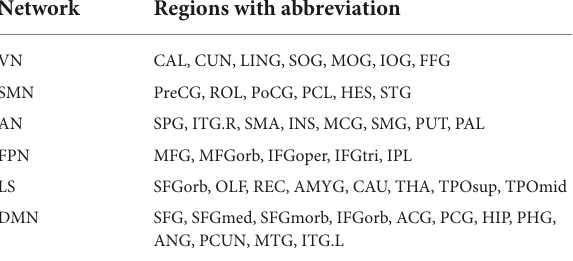
TABLE 1 Regions belonging to each functional network. Network